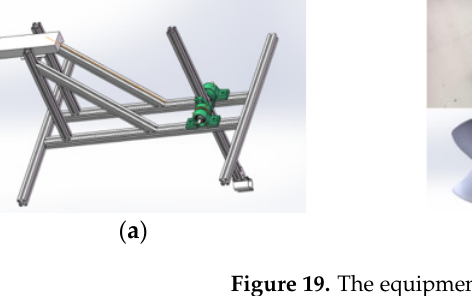
Figure 20. Propeller test and simulation results ( a ) and the error assessment of the simulation results